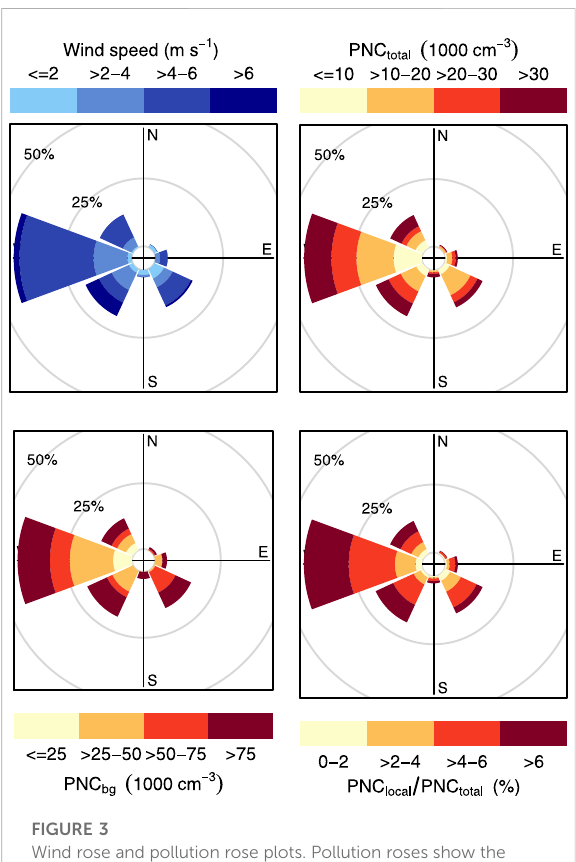
FIGURE 3 Wind rose and pollution rose plots. Pollution roses show